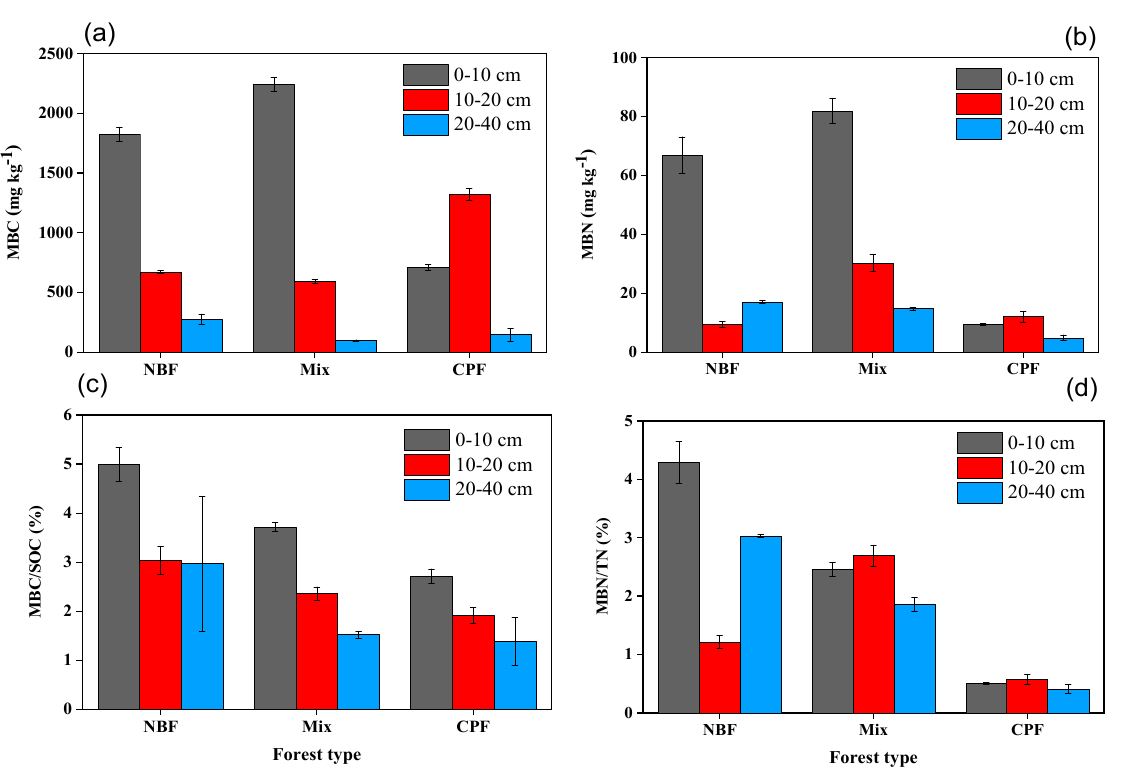
Figure 2. ( a ) Soil microbial biomass carbon (MBC), ( b ) soil microbial biomass nitrogen (MBN), ( c ) soil microbial quotient (MBC/SOC), and ( d ) soil MBN ratio to soil total N (MBN/TN) at three soil depths along NBF, mixed forest, and CPF stands. Values are means of three replicates. Based on a combined dataset for three forest types and three soil depths, strong positive linear relationships were observed for SOC and soil TN with MBC and MBN. The association values were: between SOC and MBC (R = 0.73, p = 0.01), and MBN (R = 0.46, p = 0.02), (Figure 3a,b), and soil TN and MBC (R = 0.65, p = 0.01), and MBN (R = 0.38, p = 0.02), (Figure 4a,b).